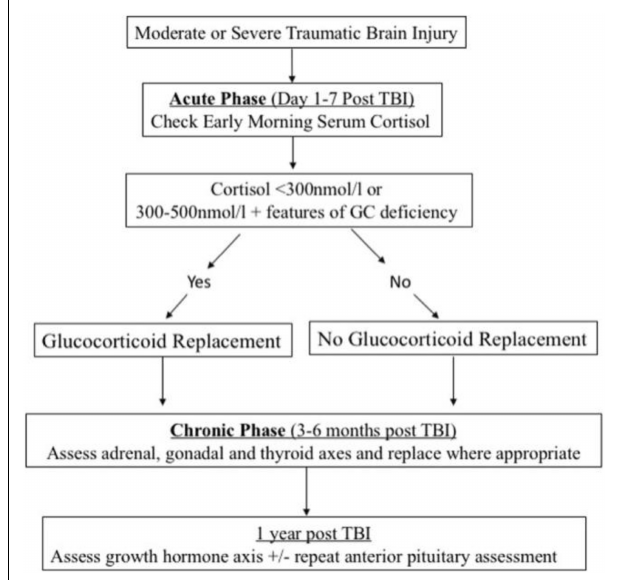
FIGURE 3 | Screening and management algorithm for post-traumatic hypopituitarism. Reproduced with permission from Quinn and Agha (2018).